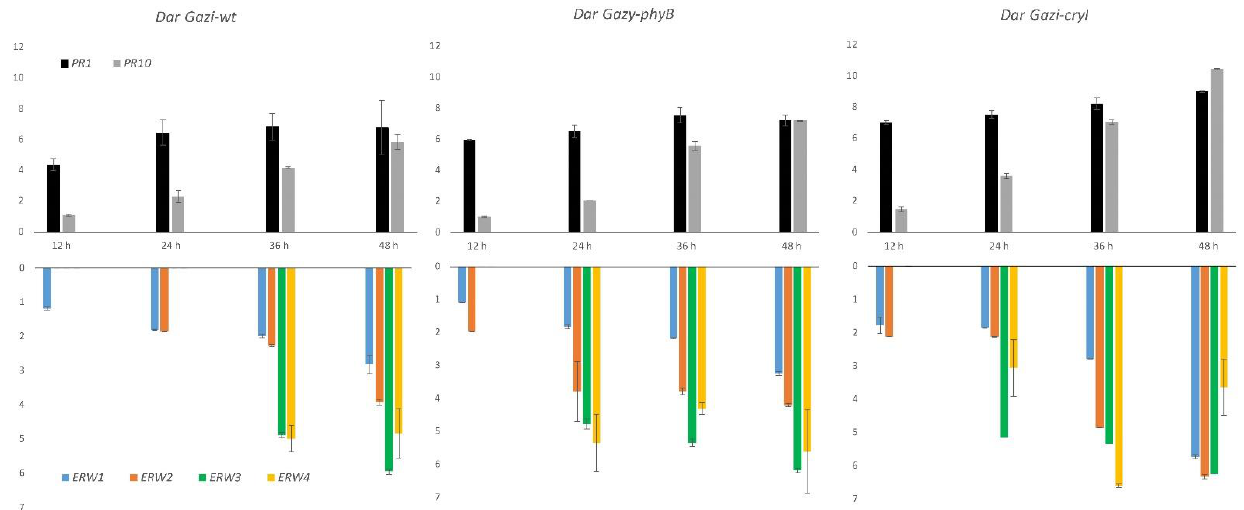
Figure 13. PR1 , PR10 , and erw1 - 4 expression in Dar Gazi-wt , Dar Gazi-phyB , and Dar Gazi-cry1 plants, grown under 16/8 h light/darkness, at 12, 24, 36, and 48 h after the pathogen inoculation. Results are presented after normalization with ef1A. Data shown are the average of two biological replicates run in triplicate, with error bars representing SD.